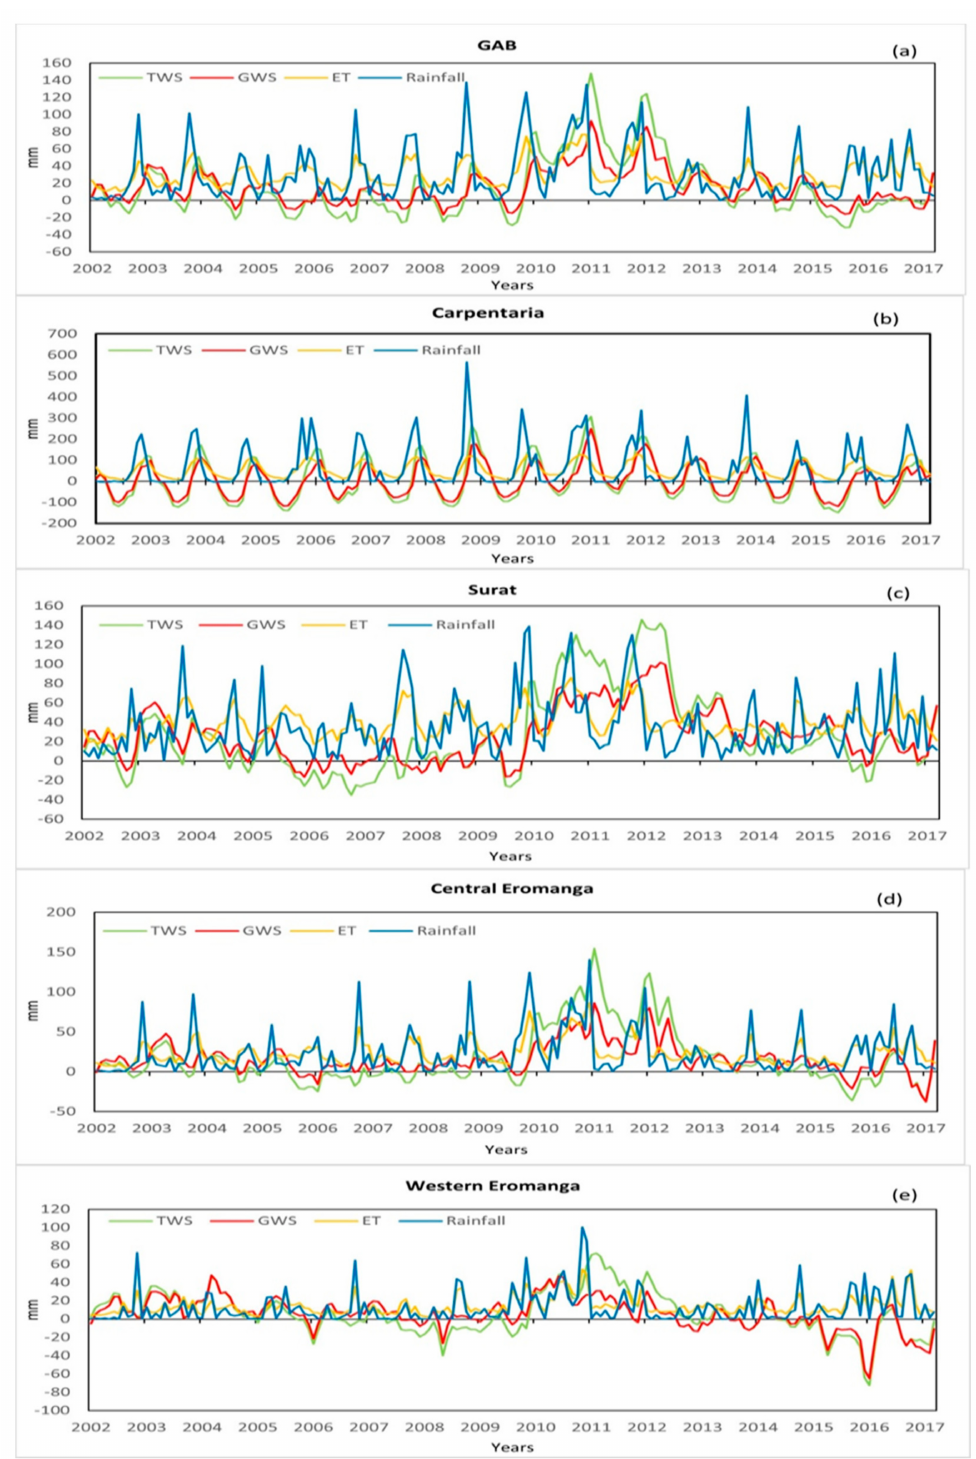
Figure 6. Variation in GWS, TWS, rainfall and evapotranspiration averaged across the entire GAB ( a ) and for the four sub-basins: Carpentaria ( b ), Surat ( c ), Central Eromanga ( d ) and Western Eromanga ( e ) for the period of